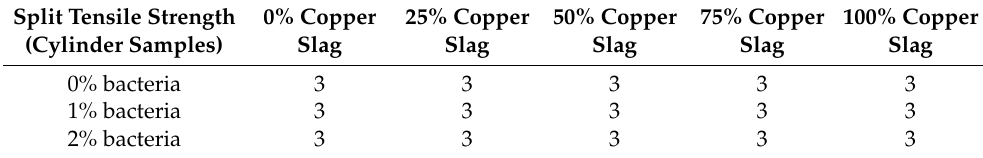
Table 8. Number of cylinder samples prepared for split tensile strength evaluation on day 7.